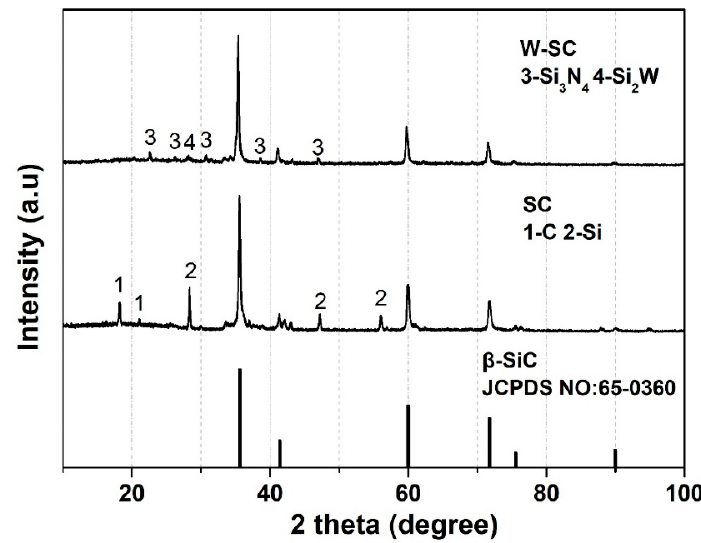
Figure 1. X-ray di ff raction (XRD) patterns of the combustion synthesized (CSed) silicon carbide Figure 1. X-ray diffraction (XRD) patterns of the combustion synthesized (CSed) silicon carbide nanowhiskers (SiC nanowhiskers (SiC NWs).